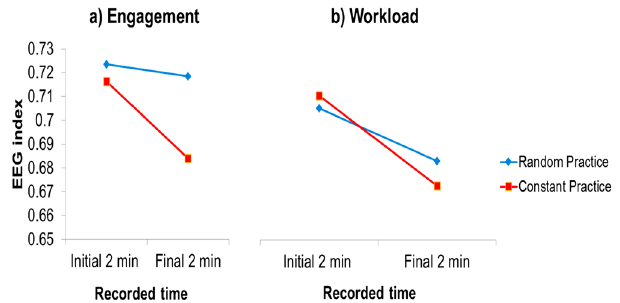
Figure 4. Means of the ( a) EEG-engagement index and ( b ) EEG-workload index in the random and constant practice conditions during the initial and final two